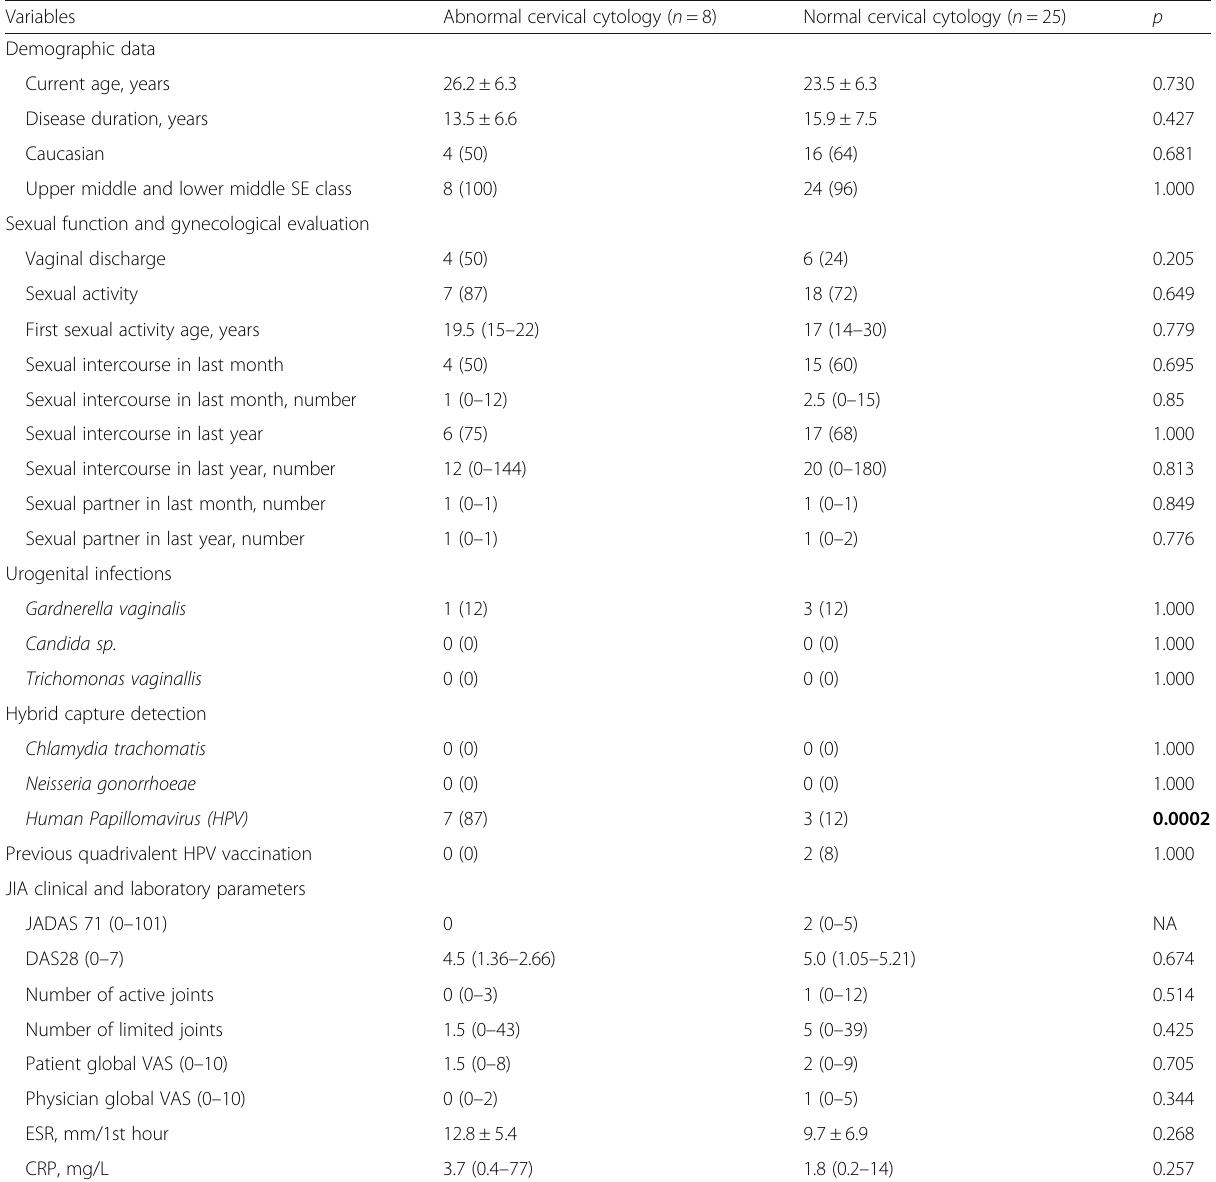
Table 3 Demographic data, sexual function, gynecological evaluation, Pap smears, genital infections and HPV vaccination and disease parameters in juvenile idiopathic arthritis (JIA) patients with abnormal and normal cervical cytology